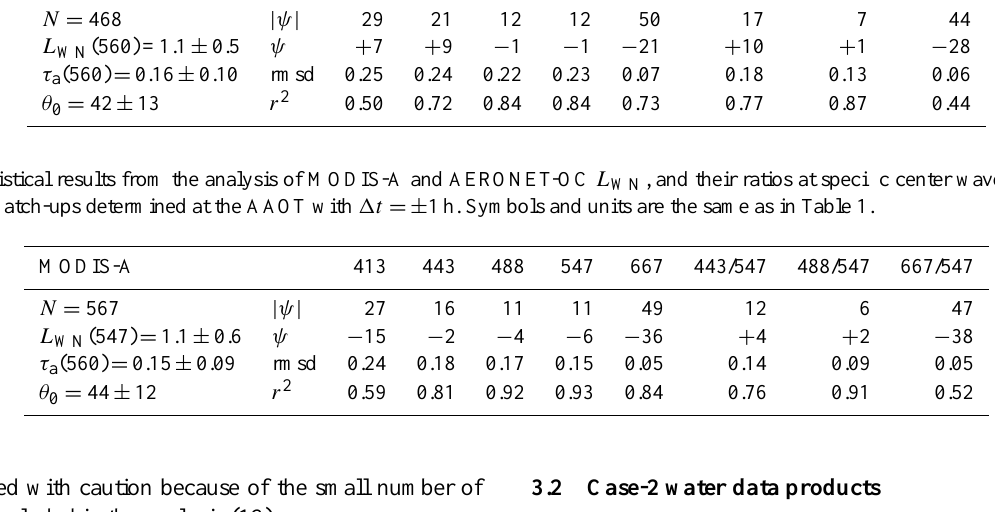
Table 7. Statistical results from the analysis of SeaWiFS and AERONET-OC L WN , and their ratios at specific center wavelengths for the match-ups determined at the AAOT with 1t =± 1h. Symbols and units are the same as in Table 1. SeaWiFS 412 443 490 555 670 N = 468 | ψ |